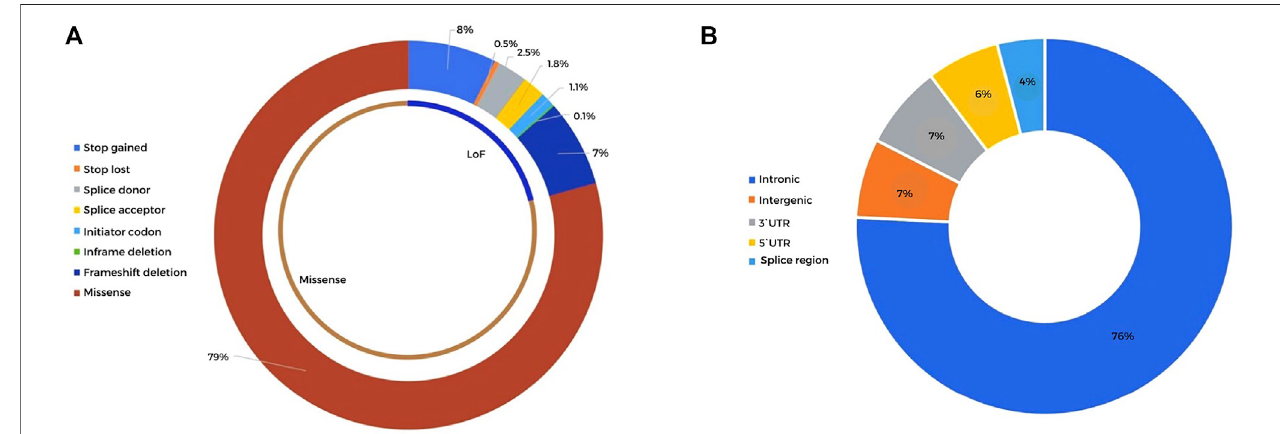
FIGURE 2 | Distribution of the detected high-quality rare coding and noncoding variants detected in 30 HB patients (A) . Sequence ontology of the rare coding variantsdetectedafterselectionbythereaddepth( > 10),Phredscore( > 20),alternativeallelefrequency( > 0.35),andpopulationfrequency( < 1%).Atotalof2,107variants were classi fi ed into 1,671 missense mutations and 436 LoF variants (B) . Sequence ontology of the rare noncoding variants detected after selection by the read depth ( > 10), Phred score ( > 20), alternative allele frequency ( > 0.35), and population frequency ( < 0.1%). A total of 2,070 noncoding variants were distributed in intronic, intergenic, and 3 ′ and 5 ′